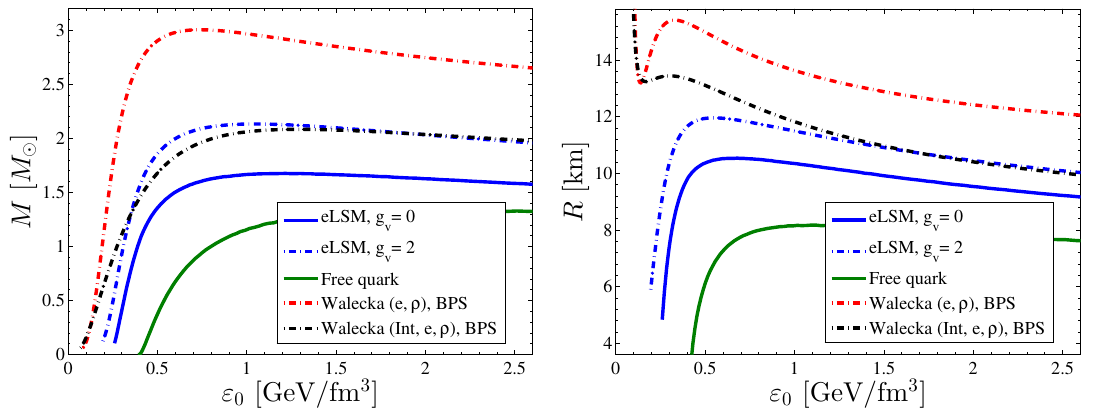
Figure 2. The masses (left panel) and radii (right panel) of the compact stars as functions of the central energy density ( ε 0 ). The line style for the different cases correspond to that of Figure 1.